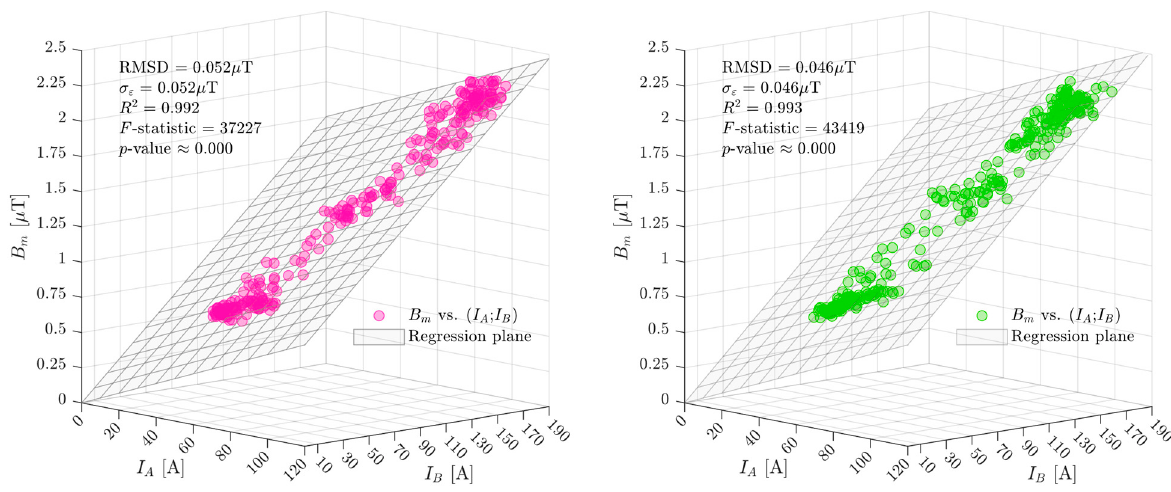
Figure 7. Regression planes together with acquired data for points P1 ( left ) and P2 ( right ). Obtained values have been used for computing the calculated field B c using Equation (18). In Figure 8 calculated field (on the x -axis) has been compared with the measured one (on the y -axis) for points P1 (left) and P2 (right). Residuals absolute values versus measured field have been reported as well. Most—if not all—of the points are well located within the ± 10% error boundary (gray areas) as visible in both cases. The same conclusion can be drawn from the histograms of the relative residuals (in %) and the associated Gaussian probability distribution functions (PDF, N ). For assessing the global behavior of from the ideal value by 6.2‰ while position P2 presents an error of about 1.6‰. RMSD and R 2 remain unchanged in comparison to Figure 7. Again, the residuals standard deviation ( σ ) presents a good match with the RMSD value. Indeed, the mean value of the percentage error distribution is only − 0.45% and 0.53% for points P1 and P2, respectively. Finally, the Pearson coefficient ( ρ ) shows the particularly good linear correlation between calculated and measured values.